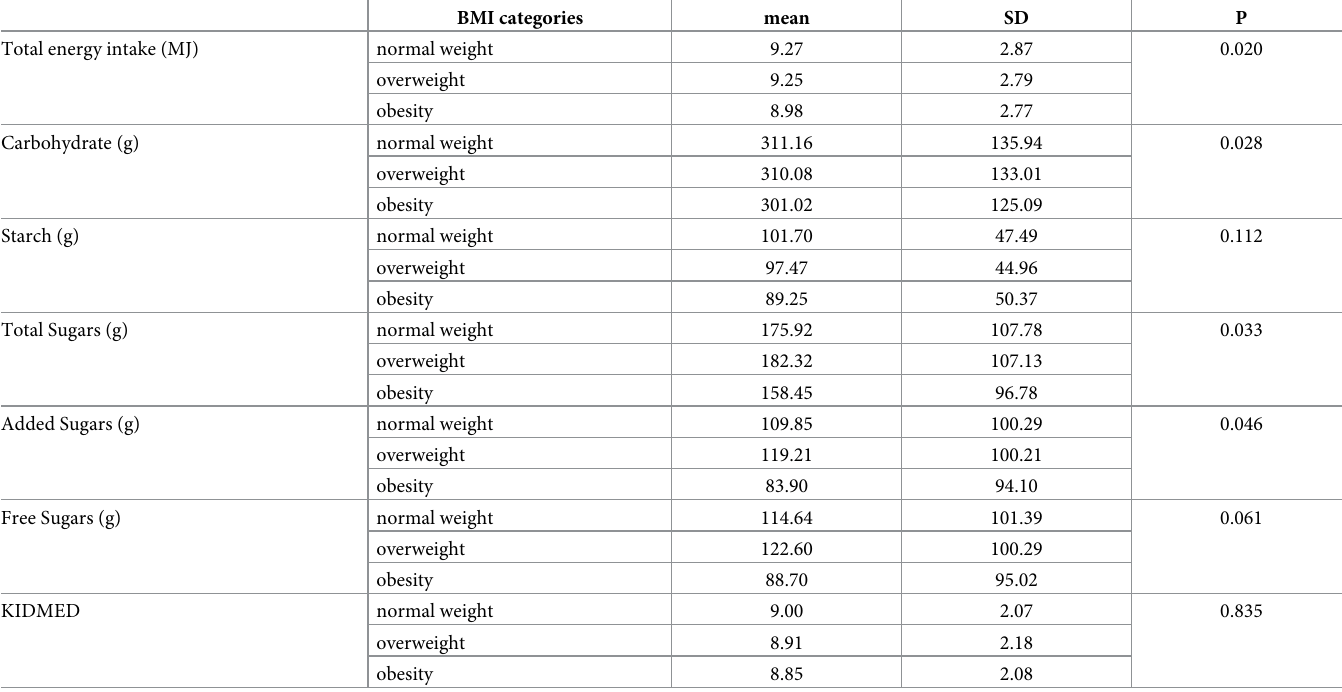
Table 3. ANOVA of the energy and carbohydrate intake (carbohydrates, starch, total sugars, and added sugars) as a function of the BMI of the study population.